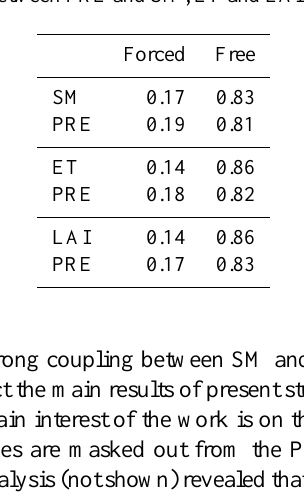
Table 2. Ratios of the global-scale forced and free variance with respect to the total variance resulting from the application of the CM technique between PRE and SM, ET and